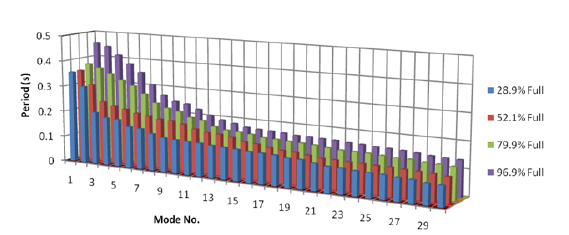
Figure 11. Comparison of vibrational periods considering the joints effects